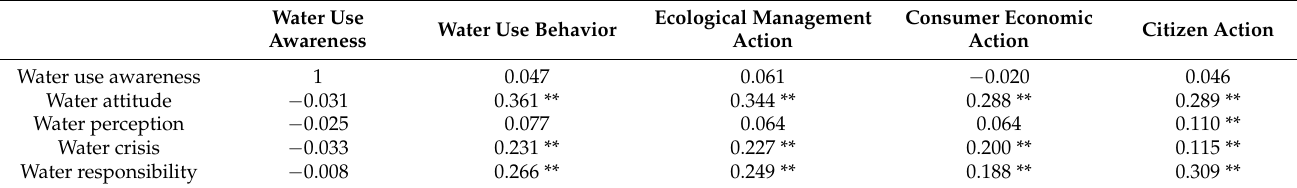
Table 5. Relevant analyses of water use awareness, attitudes, and behaviors of the Taiwanese public. Water Use